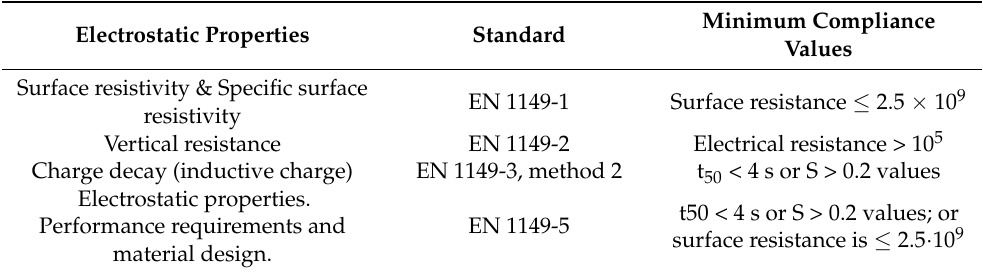
Table 4. The standards employed to evaluate electrostatic properties of the coated textiles and minimum compliance values.